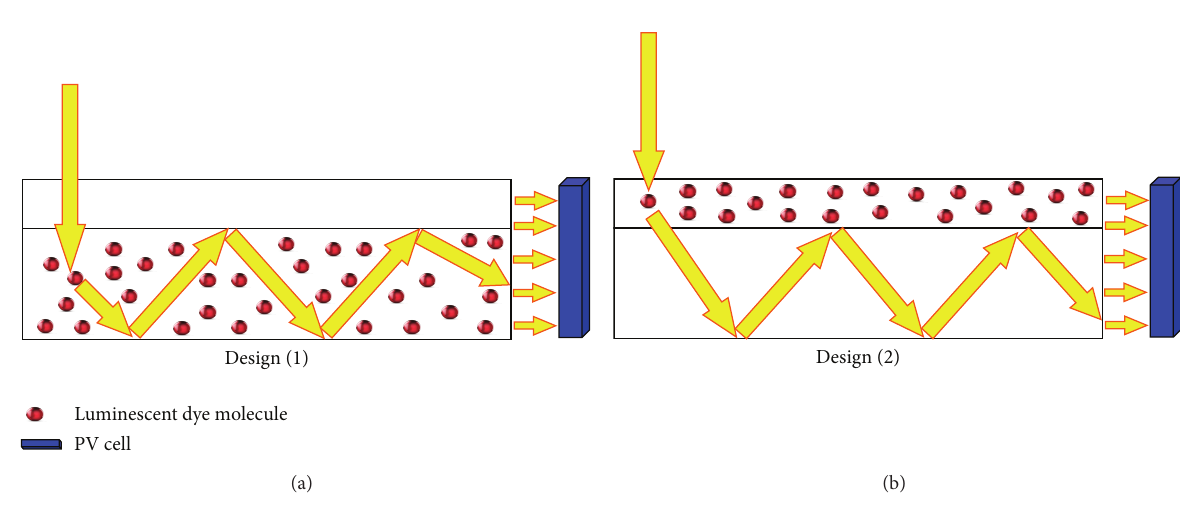
Figure 2: Outline of the fabricated TLSC